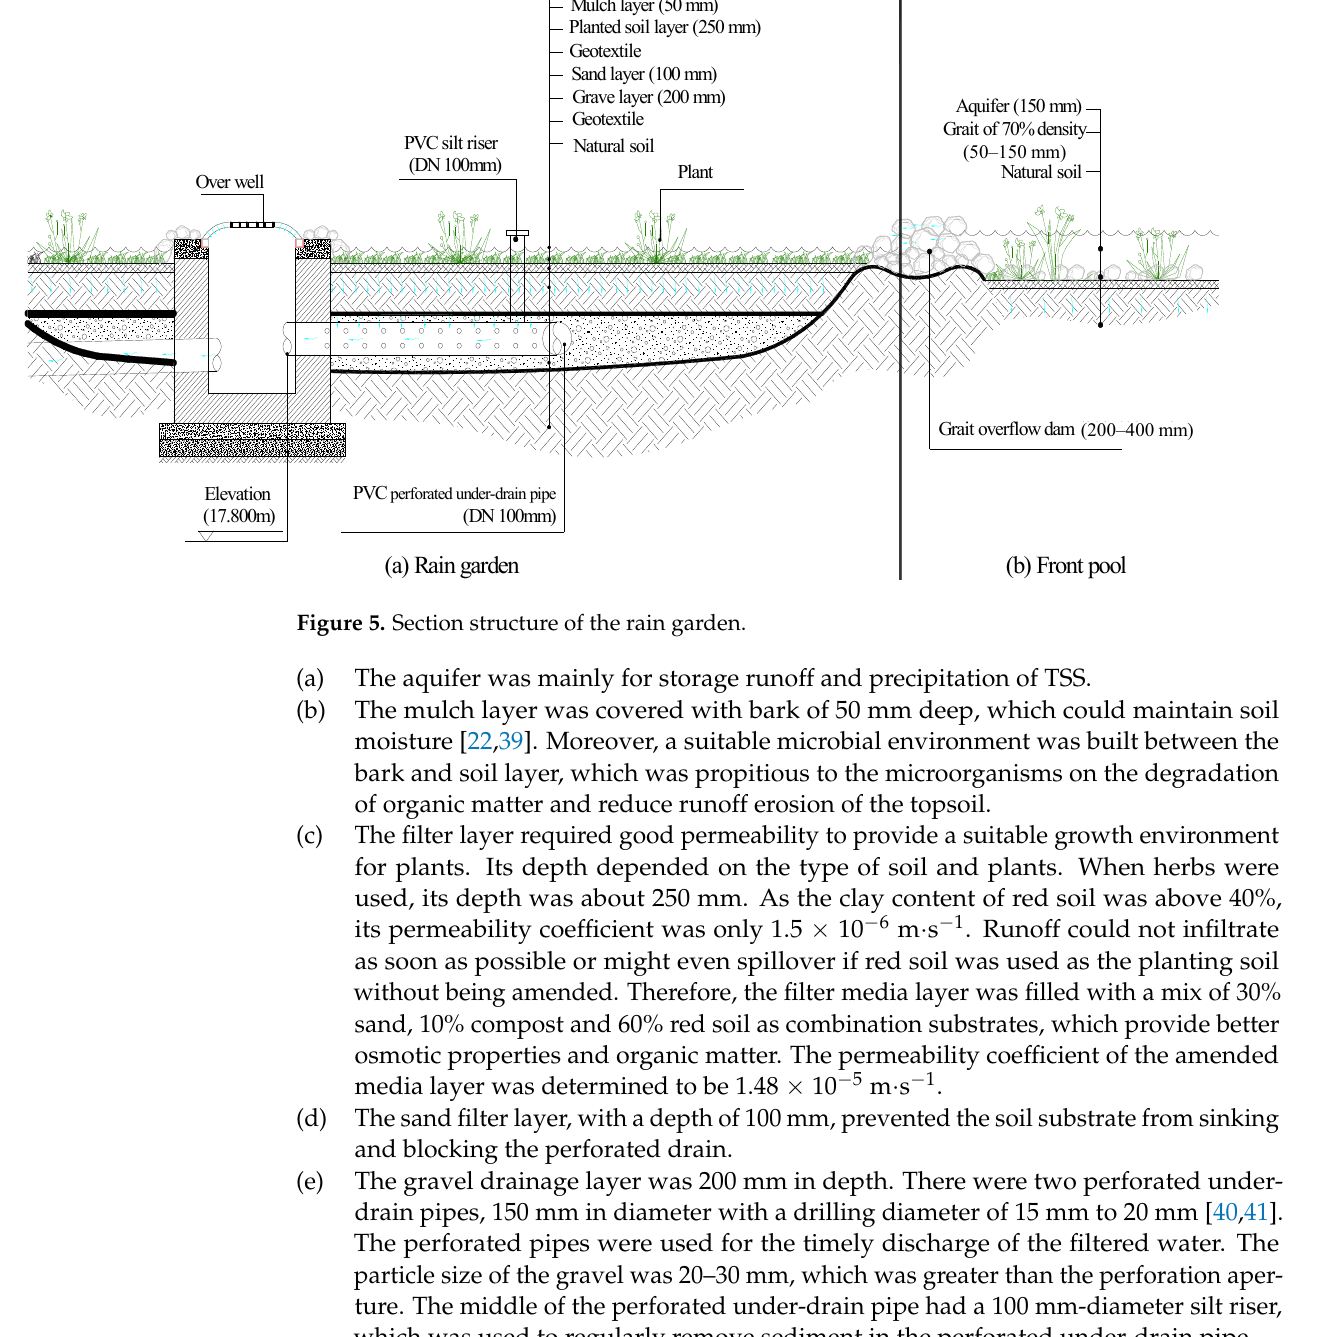
Table 2. Runoff reduction and pollutant removal efficiency data for every rainfall event.